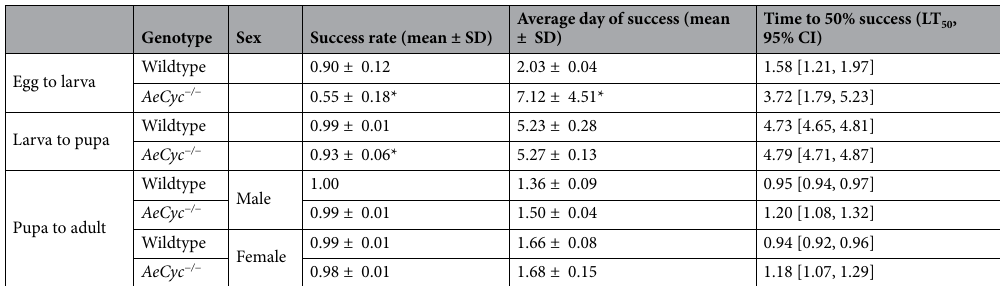
Table 1. Comparison of life history traits between AeCyc −/− and wildtype Ae. aegypti mosquitoes. *Statistically significant p ≤